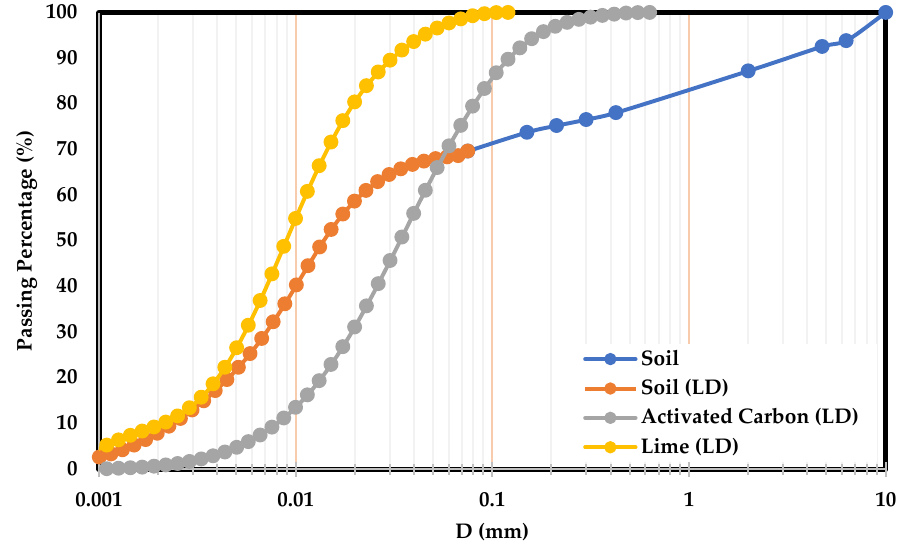
Figure 1. Particle size distribution of lime, AC, and soil.